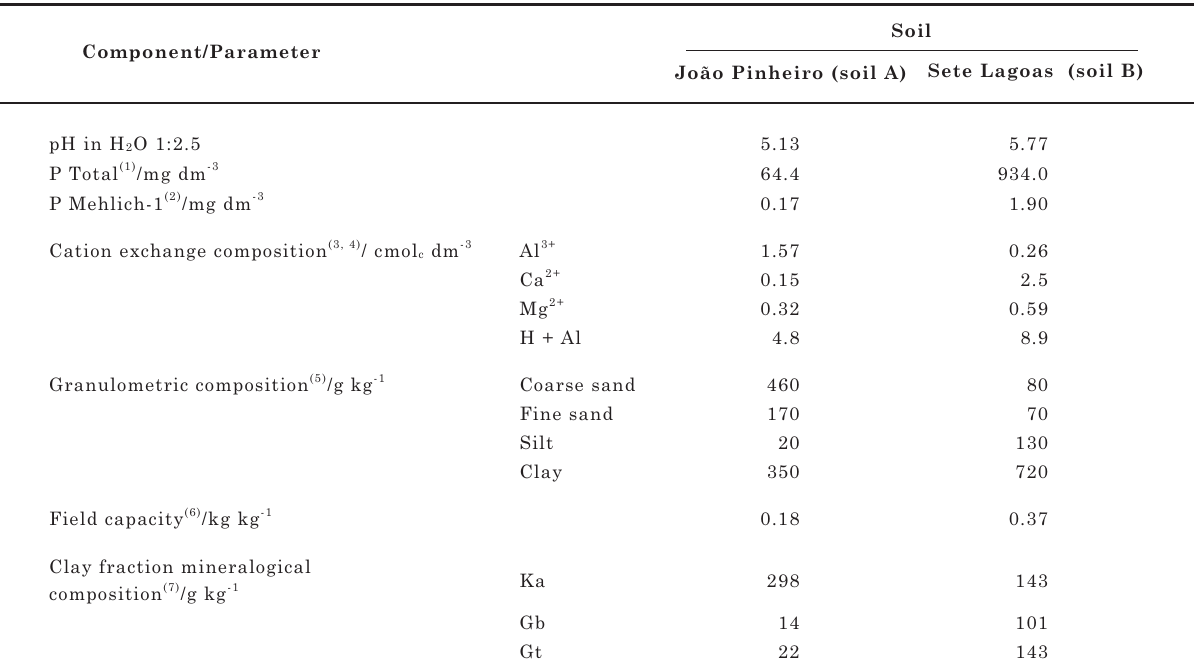
Table 1. Physical and chemical characteristics of soil samples used in the incubation experiment and mineralogical composition of the clay fraction, [kaolinite (Ka), gibbsite (Gb), and goethite (Gt)]. Adapted from Oliveira et al.,